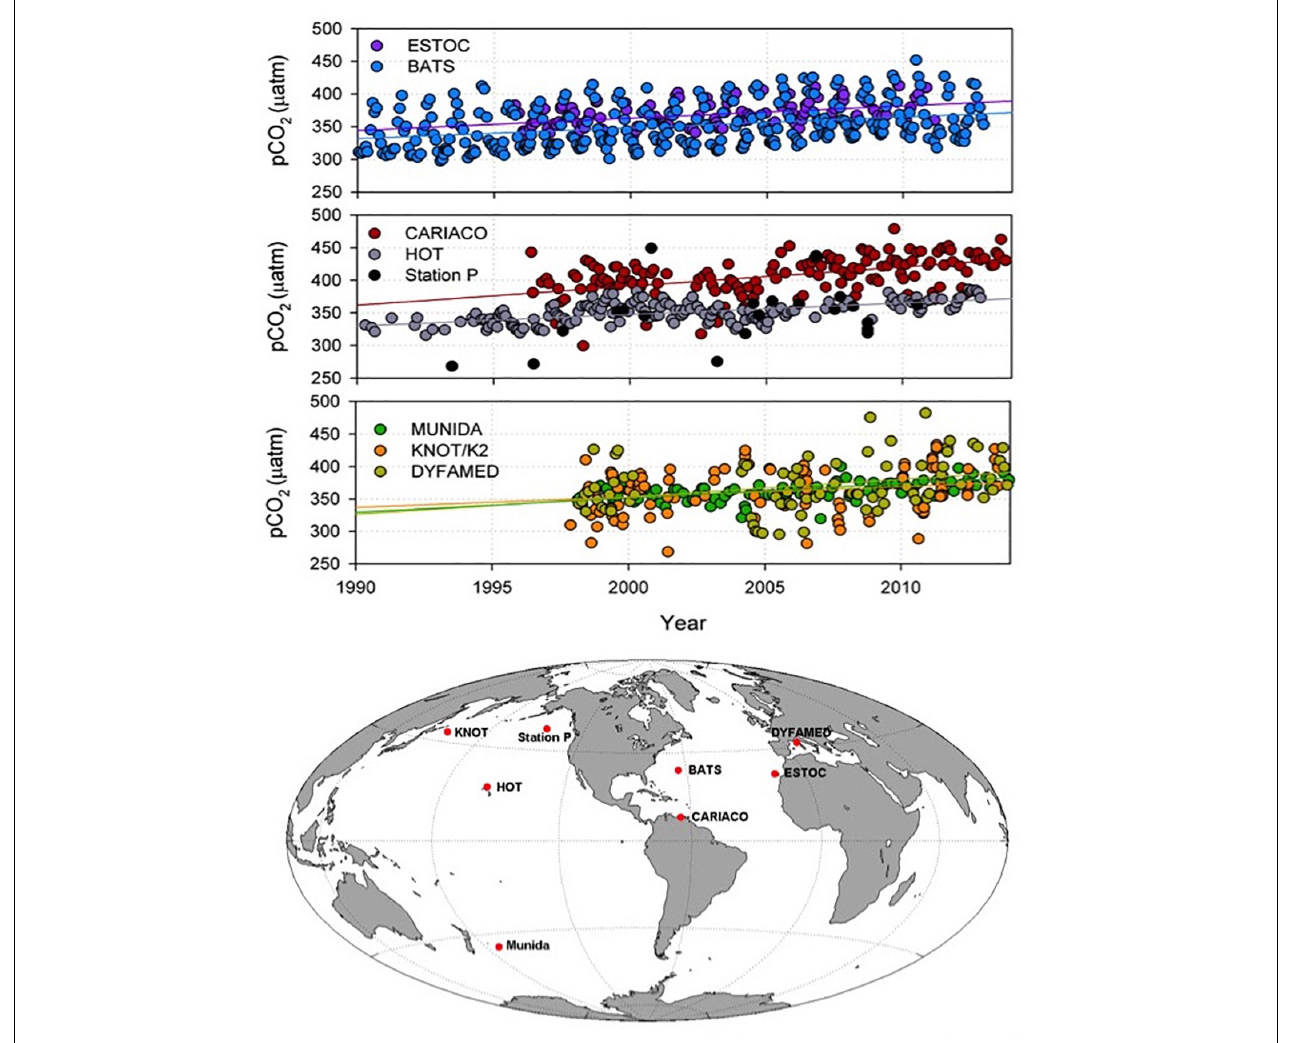
FIGURE 2 | Top: Time series observations of p CO 2 normalized for seasonal variations. Bottom: Locations of the time series stations. The increasing trend in p CO 2 observed over several decades at the time series stations is indicative of the increasing uptake of anthropogenic CO 2 by the ocean, which leads to rising ocean acidity. DYFAMED, DYnamique des Flux Atmosphériques en MEDiterranée; KNOT, Kyodo North west Pacific Ocean Time-series/K2. Figure modified from Tanhua et al.